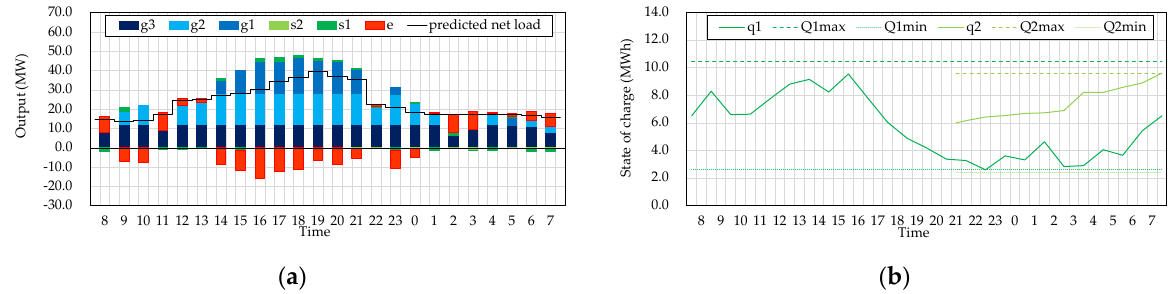
Figure 5. Optimal operation schedule on proposed framework: ( a ) Operation schedule; ( b ) Transition of SOC level.